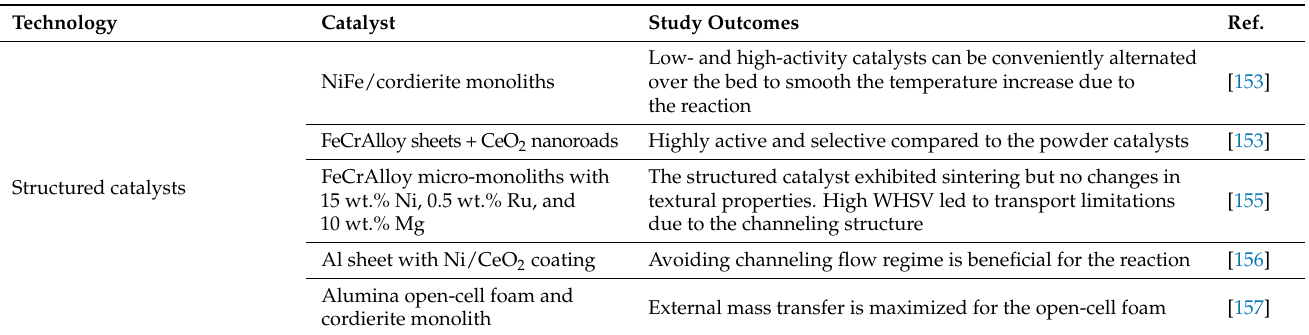
Table 7. Summary of the most recent relevant findings in CO 2 methanation reported in this